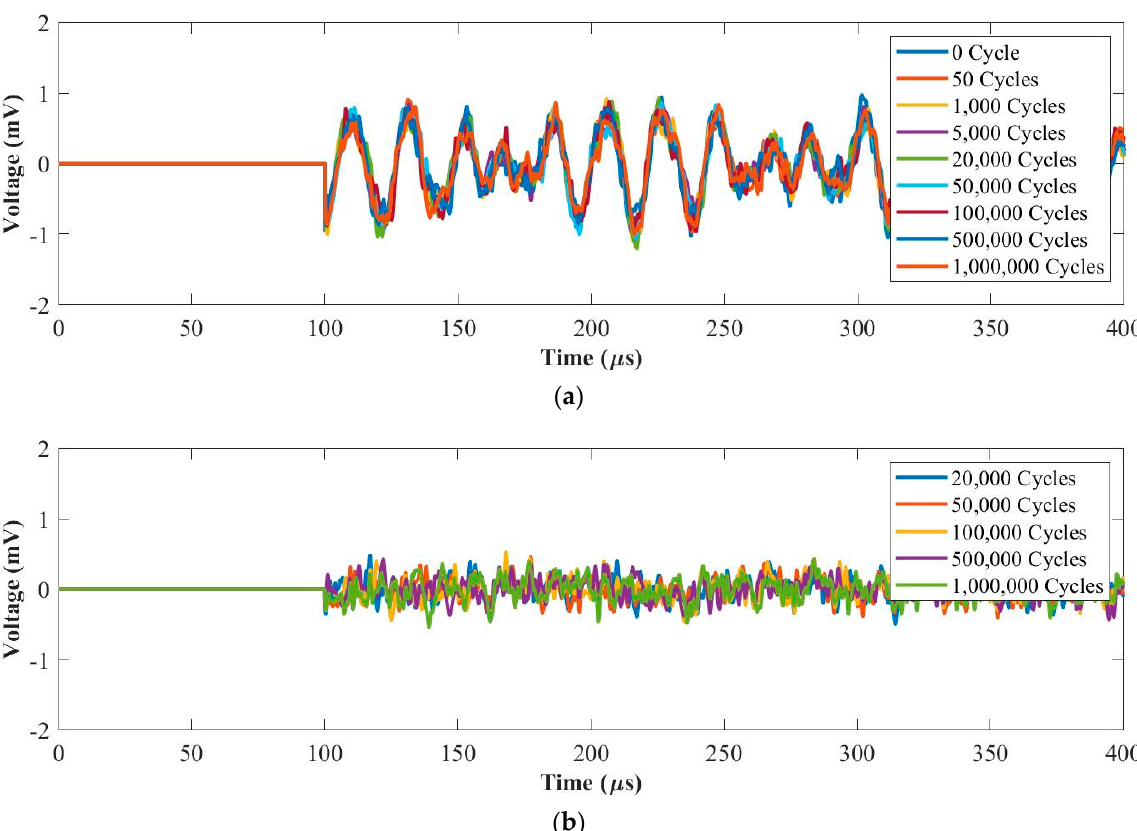
Figure 9. UGW comparisons within 1 million cycles for ( a ) original signals and ( b ) residual signals under the force range of 1~10 kN at 50 kHz.